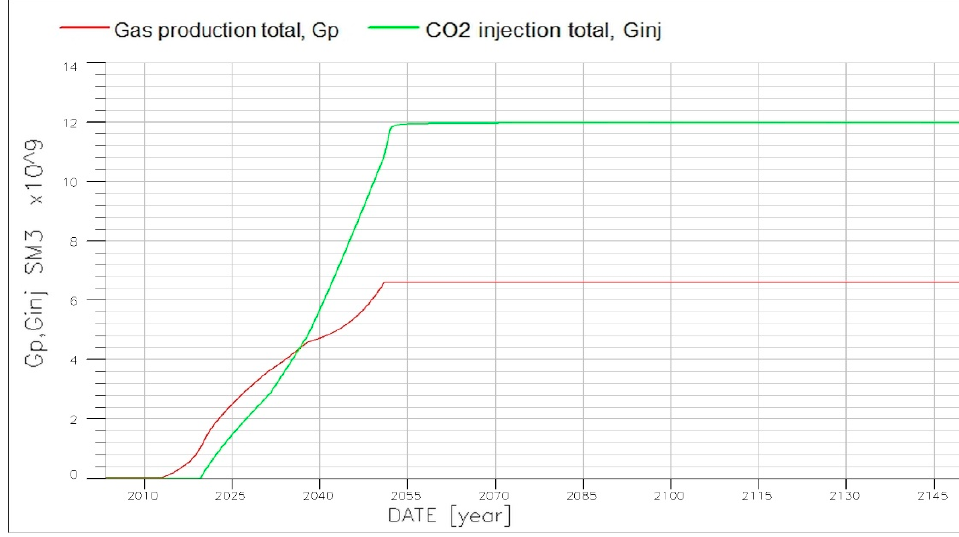
Figure 16. Basic scenario of oil production by enhanced oil recovery (EOR) with CO 2 injection. FGPT is the total gas production, and FGIT is the total CO 2 injection.